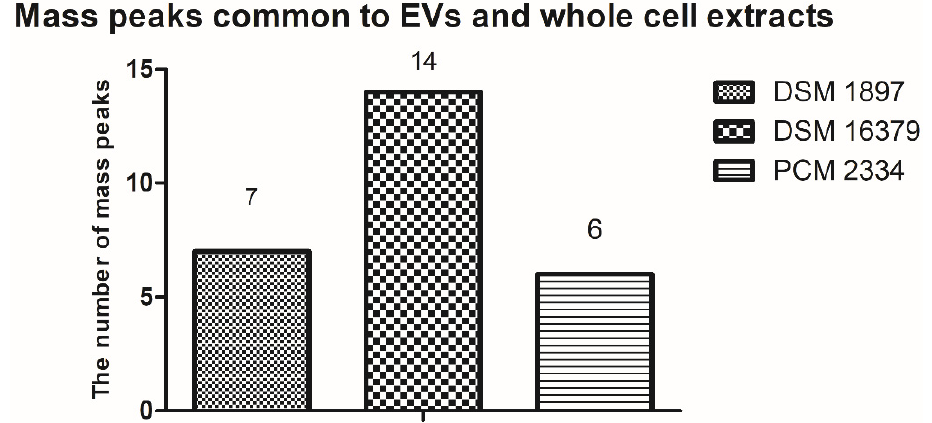
Figure 9. Comparison of the presence of common mass peaks found in EVs and whole-cell lipid extracts of C. acnes strains in MALDI-TOF MS analysis.